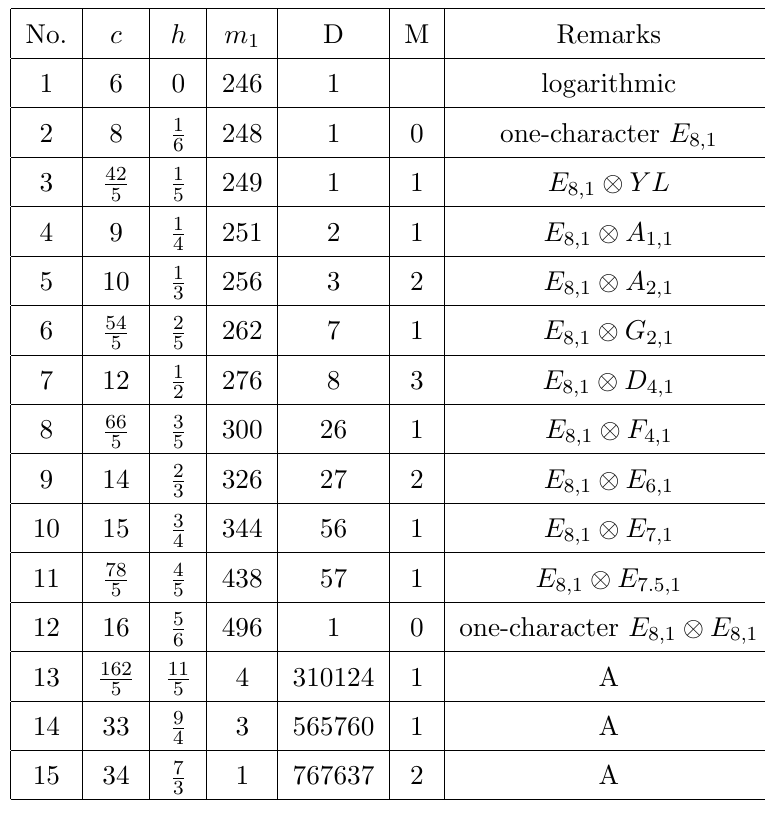
Table 3 . Potentially consistent CFT’s with ‘ =